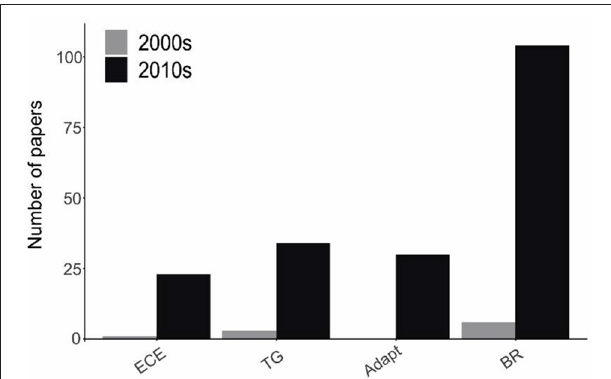
FIGURE 4 | The frequency of papers with new Marine Climate Change Experiments (MCCEs) characteristics not considered in the original study by Wernberg et al. (2012) in two decades (2000–2009 vs. 2010–2019). Reviewed papers were grouped into studies that tested for impacts of extreme climatic events (ECE), assessed transgenerational responses (TG), examined genetic adaptation (Adapt) or measured behavioral responses